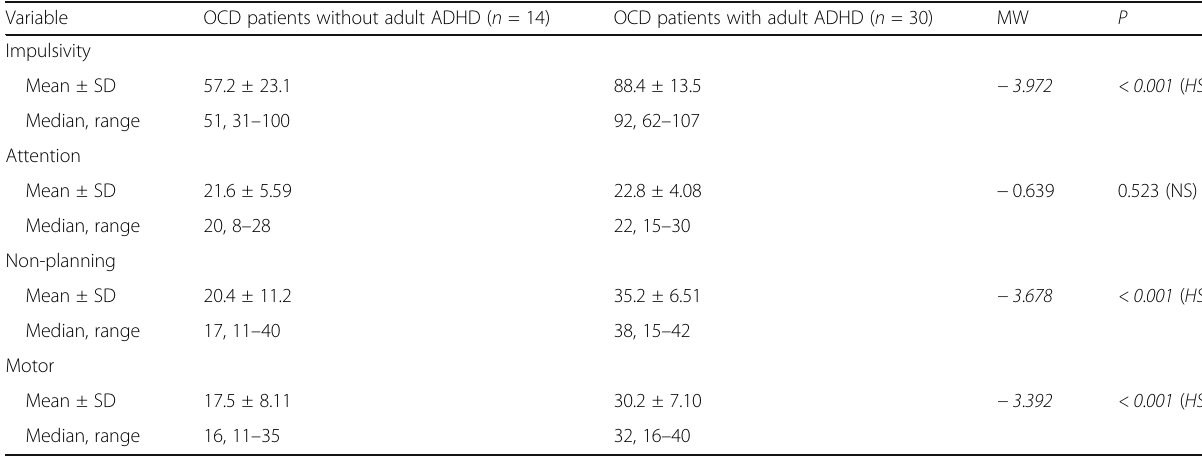
Table 1 Impulsivity among those with and without adult ADHD Variable OCD patients without adult ADHD ( n = 14) OCD patients with adult ADHD ( n =